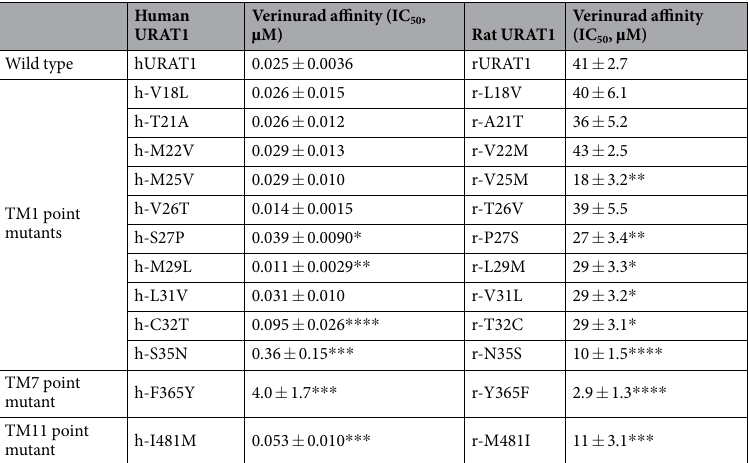
Table 2. Potency of verinurad against human (h) URAT1 and rat (r) URAT1, and chimeric point mutants in TM1, TM7 and TM11. Values (mean ± SEM) are from at least three dose-response experiments as shown in Fig. 3. Asterisks indicate significant differences in mean values from the corresponding wild type